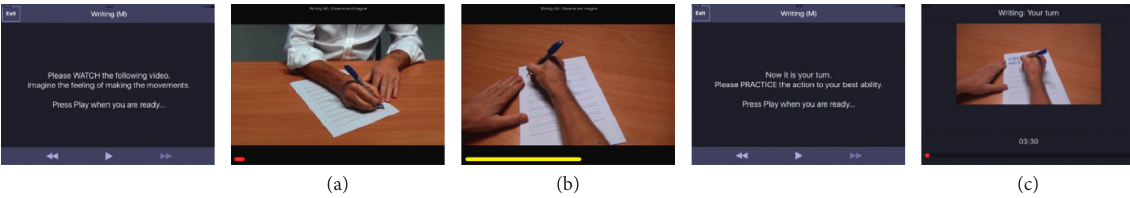
Figure 3: Screenshots of the prototype app used in the pilot RCT: participants were instructed to imagine each action (kinaesthetic motor imagery) while watching videos showing the action from the third-person (a) and first-person (b) perspectives, before physically performing the action using the relevant objects (e.g., pen and paper). A still image of the action (c) was displayed during action execution. Finally, participants rated the vividness of their imagery during observation and the difficulty of performing the Table 1: Baseline characteristics of participants in pilot testing.